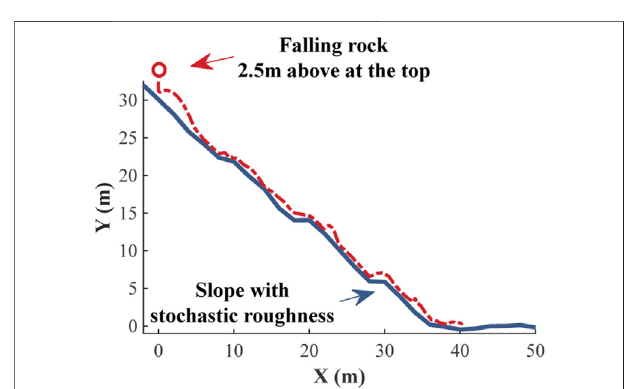
TABLE 2 | DDA control parameters.